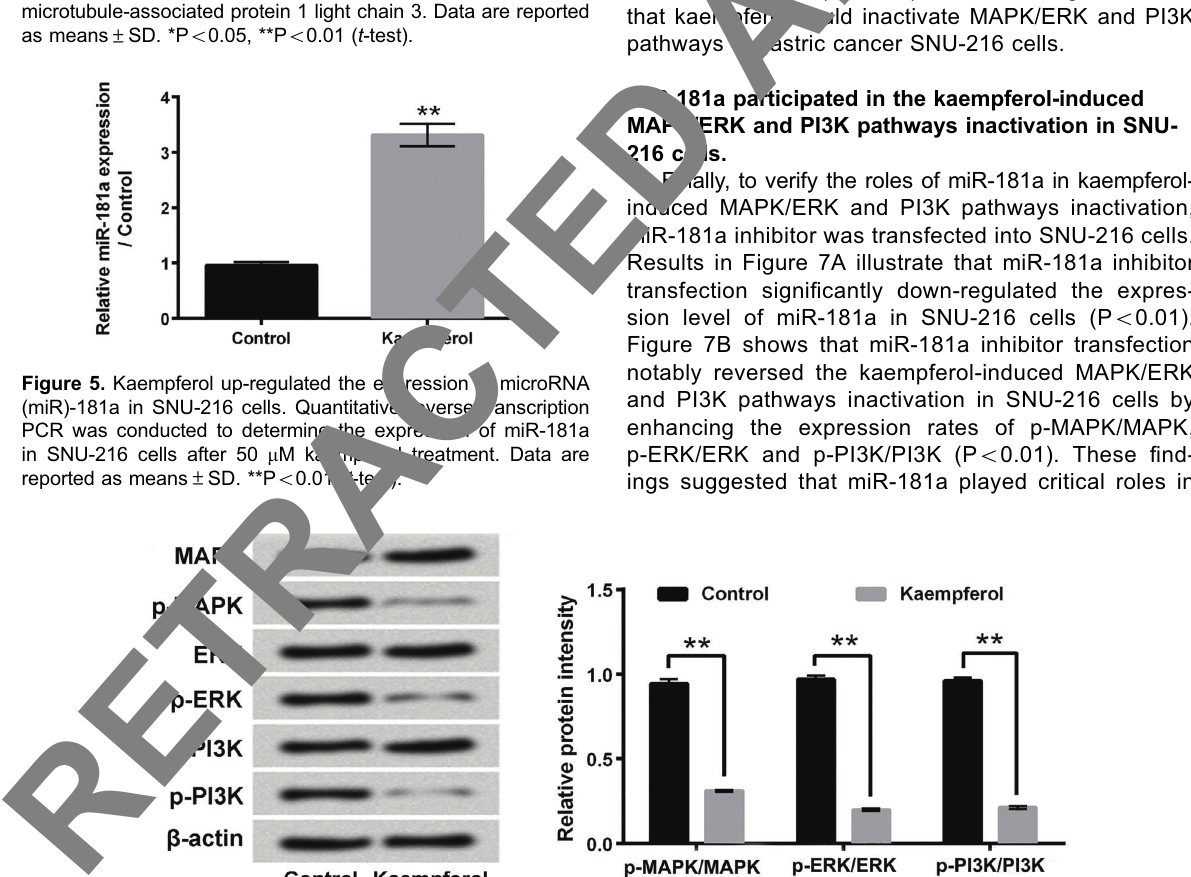
Figure 4. Kaempferol induced SNU-216 cell autophagy. After 50 m M kaempferol treatment, the protein expression levels of ATG7, LC3-I, LC3-II, beclin 1, and p62 in SNU-216 cells were evaluated using western blotting. ATG7: autophagy-related gene 7; LC3: